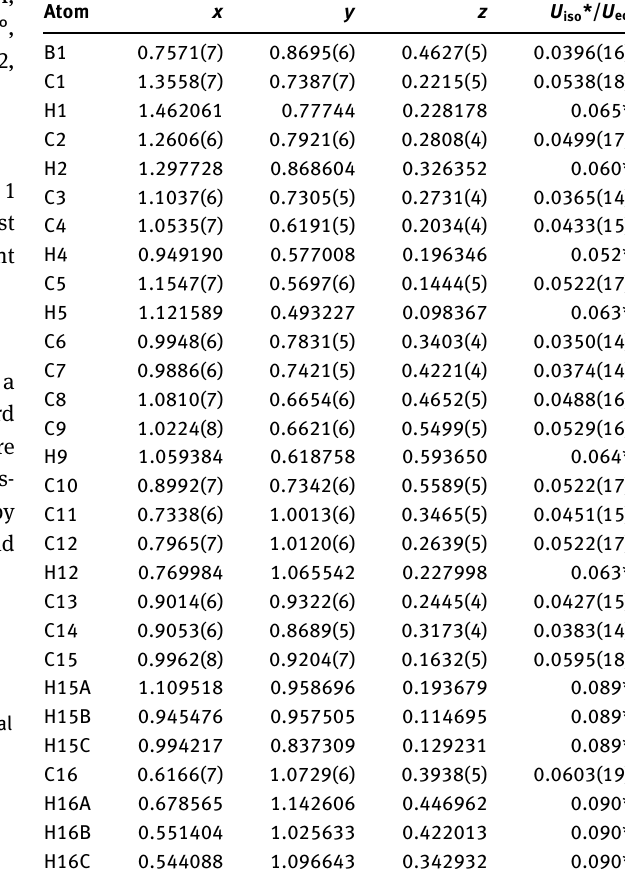
Table 2: Fractional atomic coordinates and isotropic or equivalent isotropic displacement parameters (Å 2